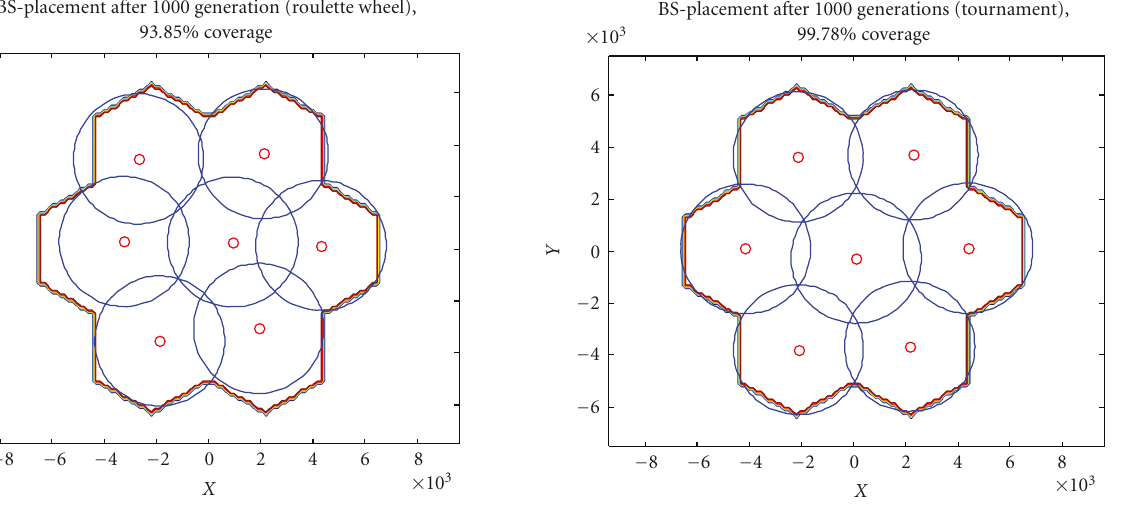
Figure 16: After the 1000th generation, base station location with tournament selection.